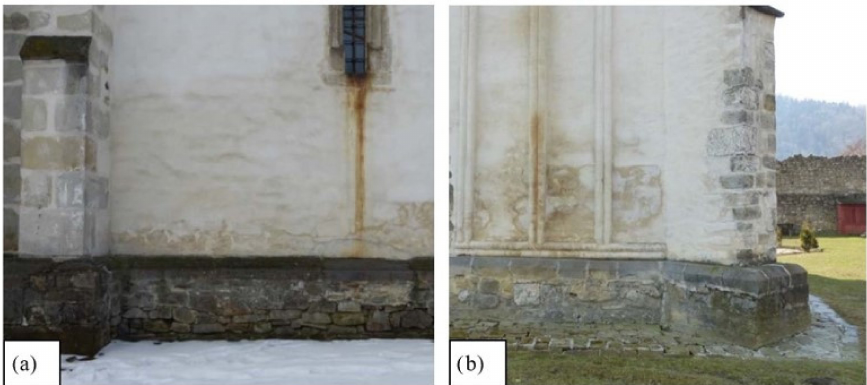
Figure 5. Examples of degradation patterns in the church of the Nativity of the Blessed Virgin Mary: ( a ) darkening due to rising damp in the façade, ( b ) salt efflorescence.